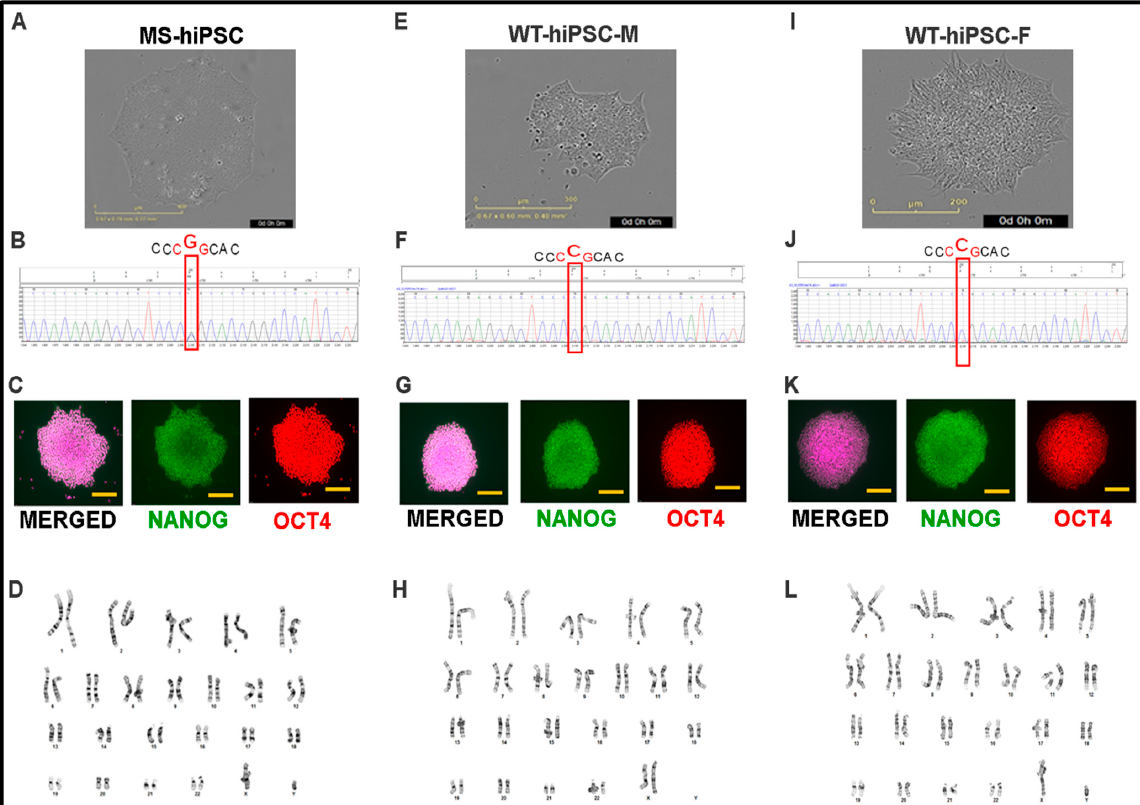
Figure 6. Human induced pluripotent stem cell (hiPSC) generation from a patient with Muenke syndrome (MS) and his unaffected parents. ( A – D ): Characterization of hiPSCs derived from a MS patient (MS-hiPSCs). ( E – H ) Characterization of hiPSCs derived from the mother (WT-hiPSC-M). ( I – L ): Characterization of hiPSCs derived from the father (WT-hiPSC-F). ( A , E , I ): Morphology of MS-hiPSCs and WT-hiPSCs. ( B , F , J ): PCR showing the FGFR3 p.Pro250Arg mutation in MS-hiPSCs and its absence in WT-hiPSCs. ( C , G , K ): Immunofluorescent staining showing expression of pluripotent markers. Non-immune immunoglobulins of the same isotypes were used as negative controls (Supplementary Table S5). ( D , H , L ): Karyotyping of MS-hiPSCs and WT-hiPSCs.